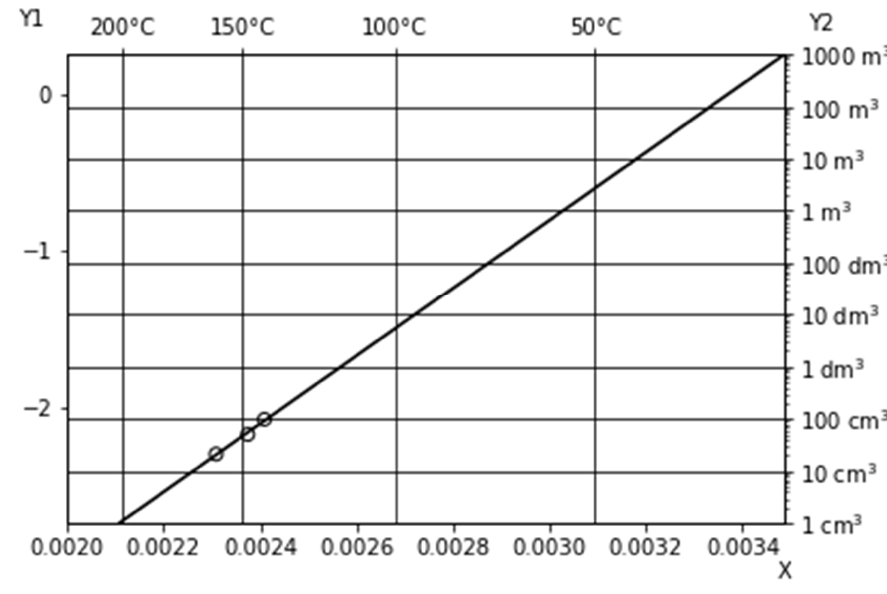
Figure 10. Pseudo-Arrhenius graph of the self-ignition temperature of the sludge dust. The dependence of the induction time of the combustion (t i ) on the volume/surface ratio of the sludge dust is shown in Figure 11. It yields the determination of the time needed for a sample to undergo spontaneous combustion when stored at temperatures slightly higher than T SI by an extrapolation method. A line through the t i values separates areas representing stable (above the line) and unstable (below the line) dust behavior.